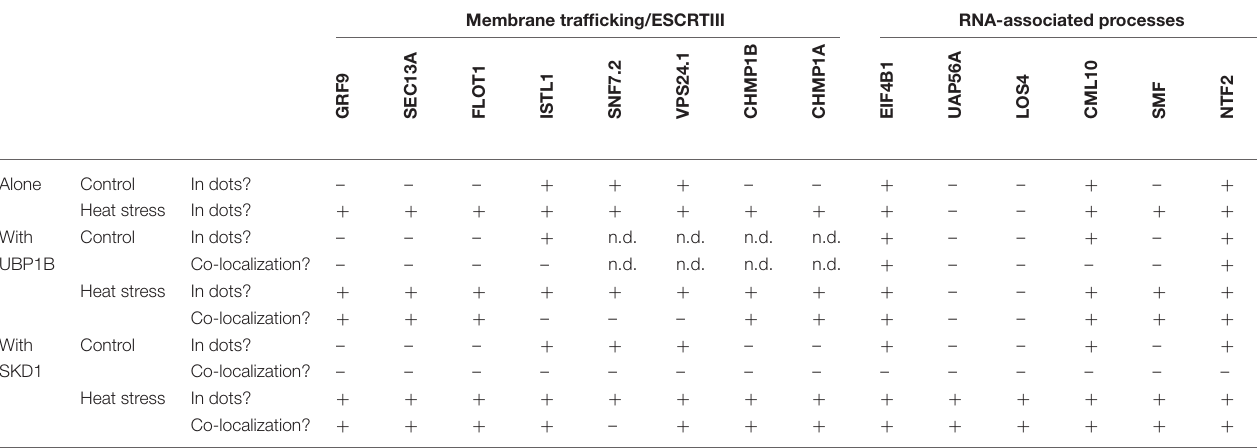
TABLE 3 | Summary of subcellular localization of ESCRTIII and SKD1 interactome